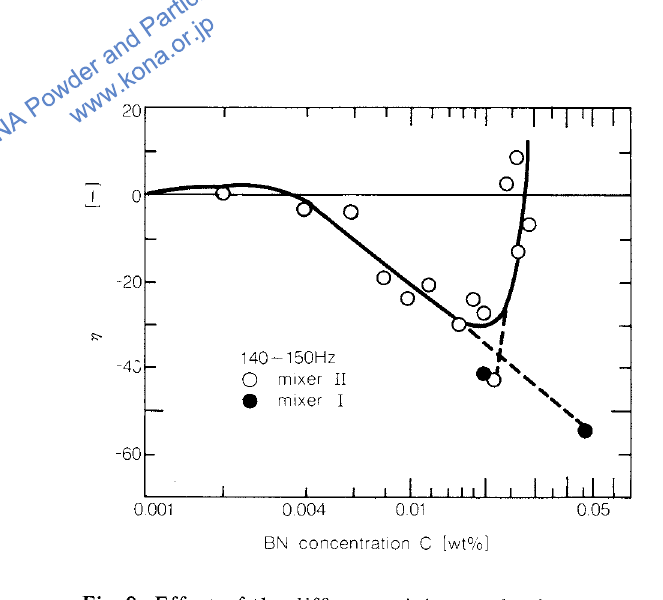
Fig. 8 Effect of the different mixing mechanisms